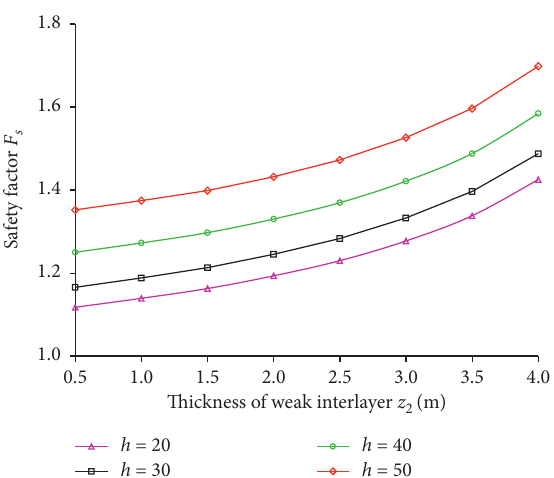
Figure 8: Relationship between the safety factor and thickness of the weak interlayer.